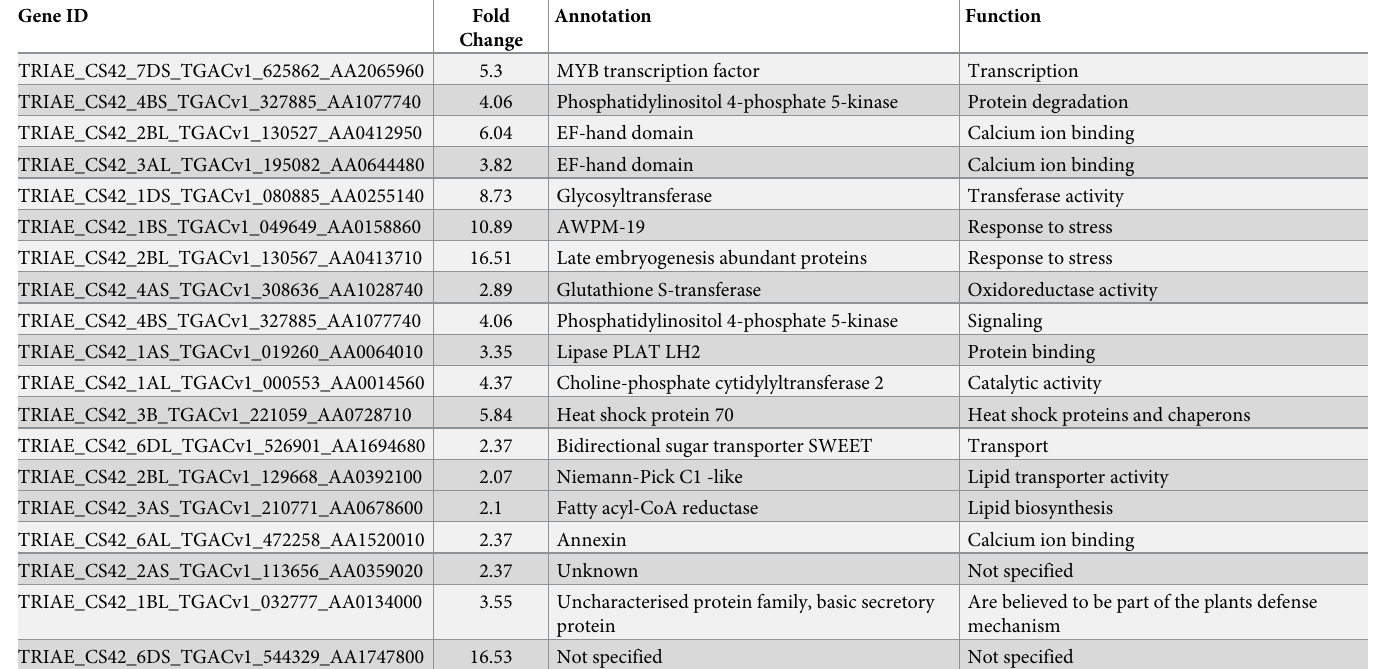
Table 4. List of specific genes which are significantly up-regulated in MD vs. MN.